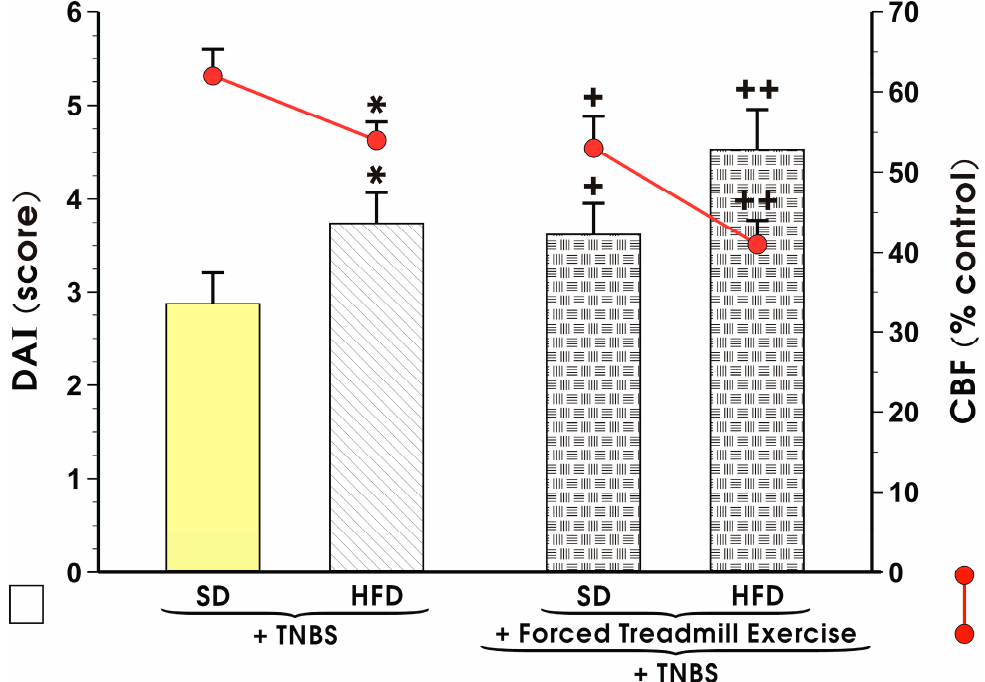
Figure 1. E ff ect of exercise on the disease activity index (DAI) and the accompanying alterations in colonic blood flow (CBF) presented as red line in this Figure in sedentary mice with TNBS-induced colitis fed standard diet (SD) or high-fat diet (HFD) with or without forced treadmill exercise. Results are Mean ± S.E.M. of 8 animals per each group. An asterisk indicates a significant change ( p < 0.05) as compared to respective values in sedentary mice fed SD. Cross indicates a significant change in ( p < 0.05) as compared to the respective values obtained in animals fed SD not subjected to forced exercise. Double crosses indicate a significant change in ( p < 0.05) as compared to the respective values obtained in animals fed SD with forced